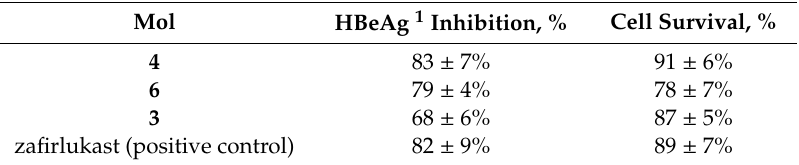
Table 3. HBV inhibition in vitro measuring with the HepAD38 line, carrying the stably integrated HBV genome under the tetracycline-regulated promoter control (10 µ M concentration of compounds 3 , 4 and 6 ). Mol HBeAg 1 Inhibition, % Cell Survival, % 4 83 ± 7% 91 ± 6% 6 79 ± 4% 78 ± 7% 3 68 ± 6% 87 ± 5% zafirlukast (positive control) 82 ± 9% 89 ± 7% 1 HB-antigen of e-class virus